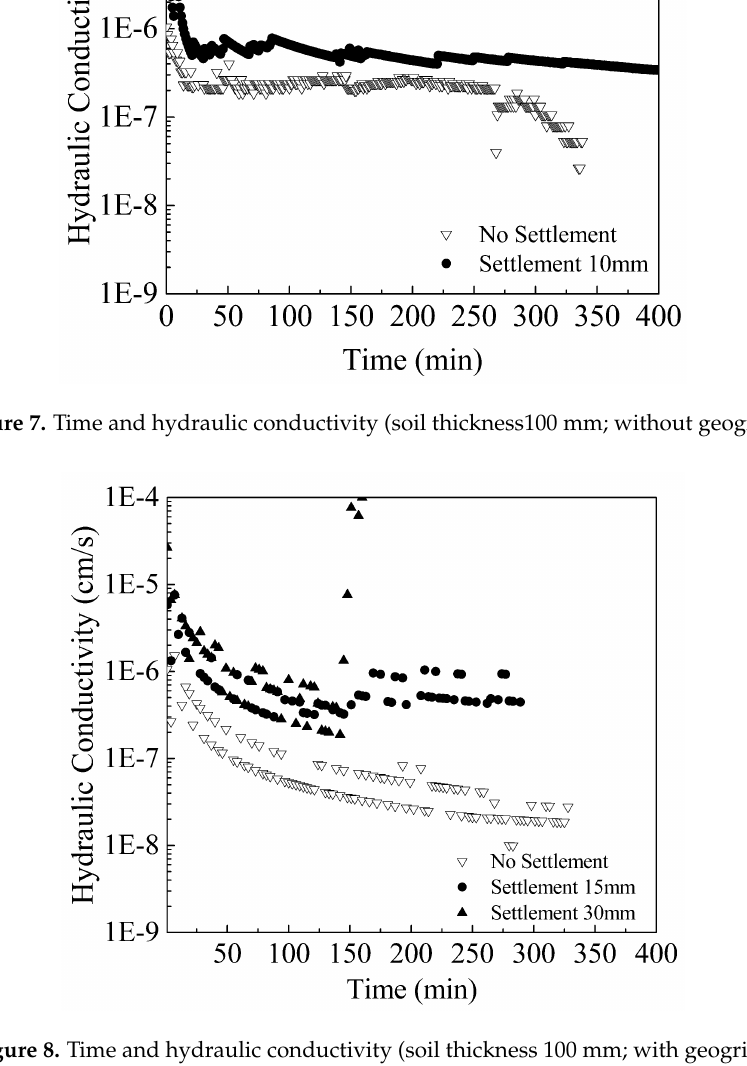
Figure 8. Time and hydraulic conductivity (soil thickness 100 mm; with geogrid).